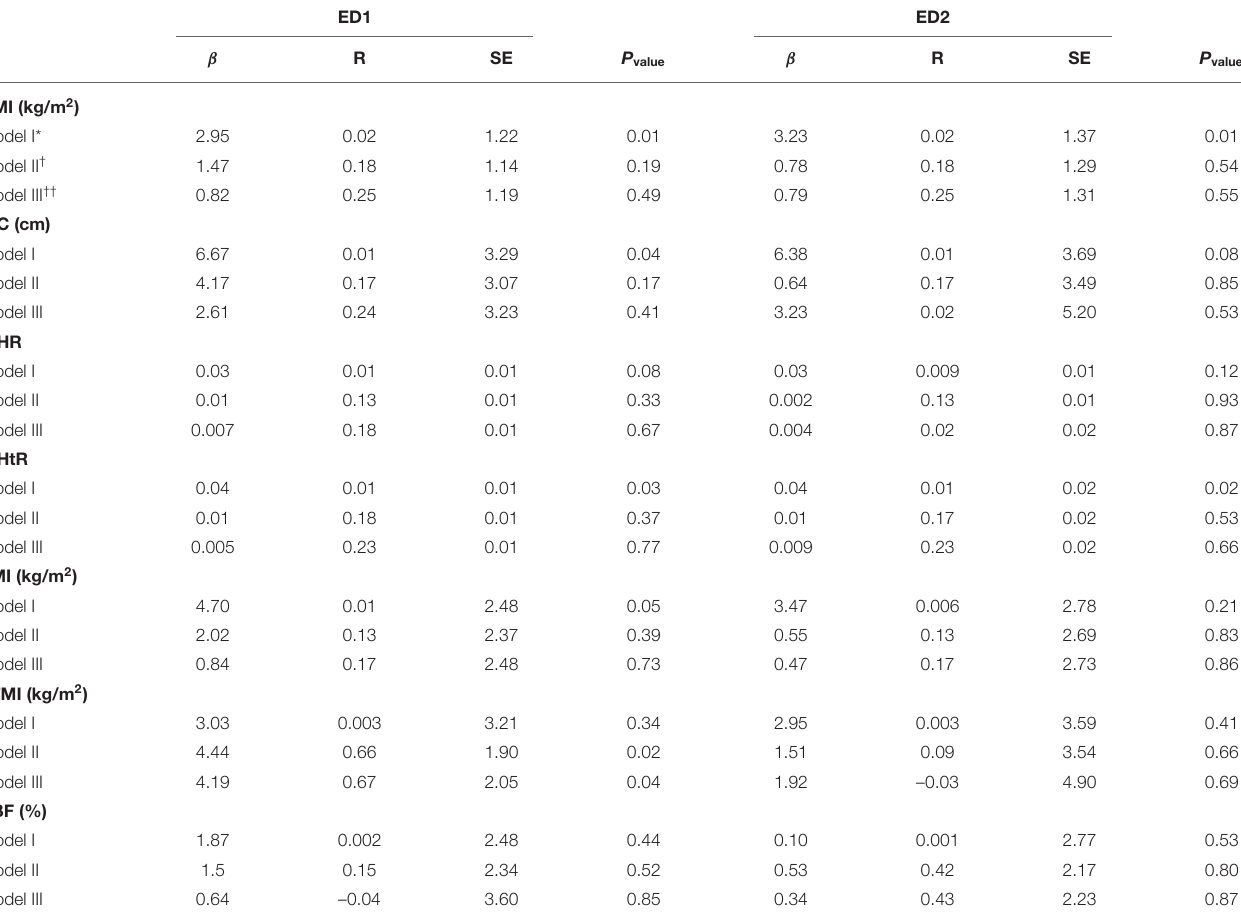
TABLE 3 | Multiple regression analysis models exploring the association of DED with WC, FMI, and body composition components in a sample of Iranian adults. ED1 ED2 β R SE P value β R SE P